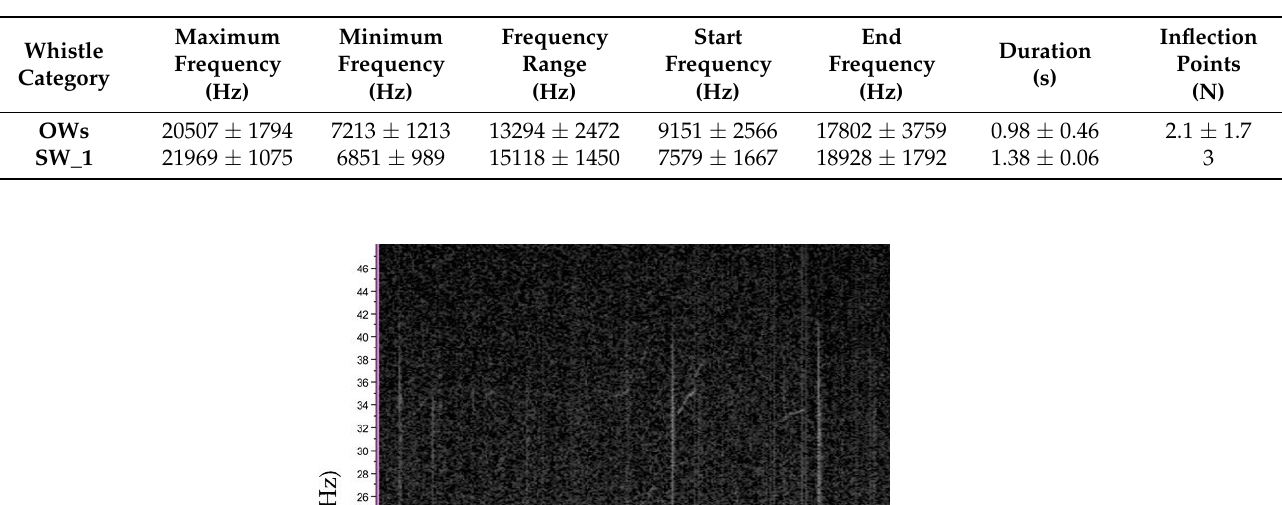
Table 3. Mean ± standard deviation of each acoustic parameter extracted from good and high- quality whistles.